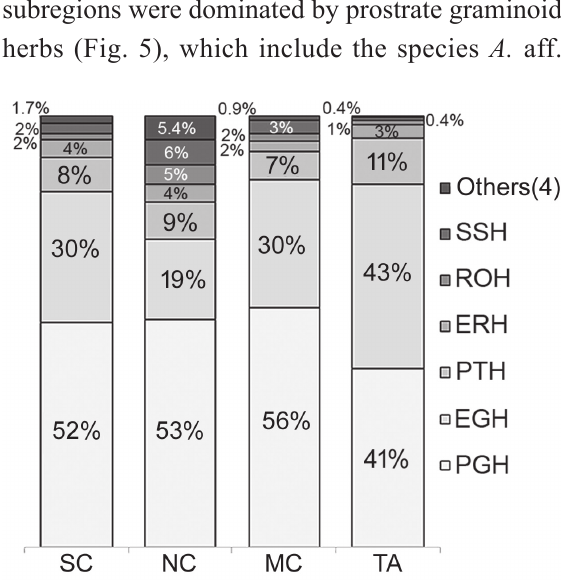
Figure 5 - Percentage of cover of species growth form in the four subregions. Growth forms are: EGH - erect (cespitose) graminoid herb; PGH - prostrate graminoid herb; ERH - erect herb; PTH - prostrate herb; ROH - rosulate herb; VIH - herbaceous vine; VIW - woody vine or liana; SSH – subshrub; SHR – shrub; and CRA - succulent